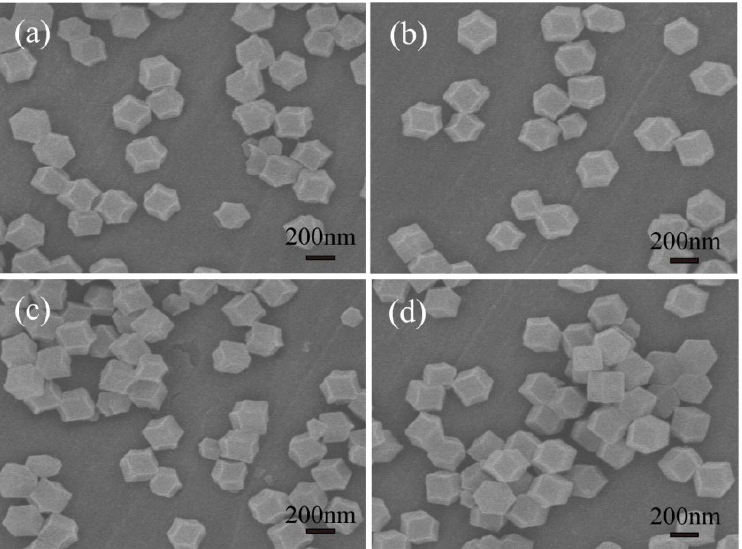
Figure 3. SEM images of ( a ) ZIF-8 and ( b – d ) Cu-doped ZIF-8 with different Cu contents (1 at%, 3 at%, 5 at%).